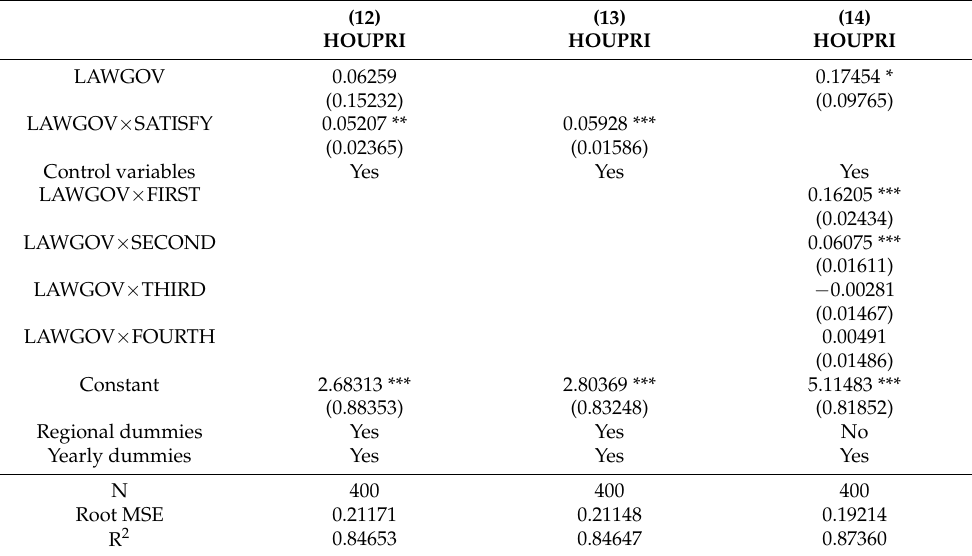
Table 8. Sensitivity and heterogeneity of the relationship between law-based governance and housing